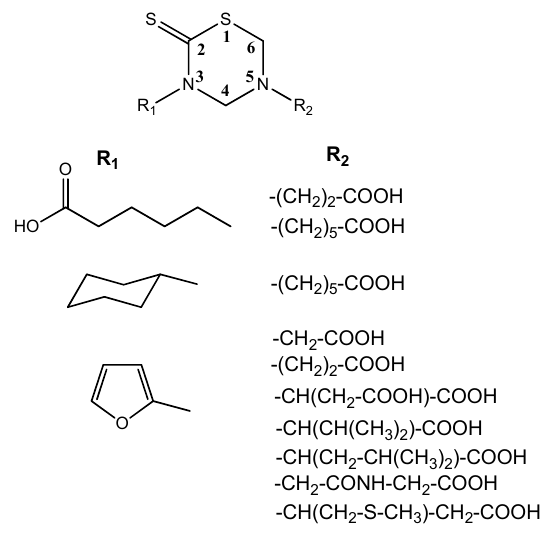
Figure 3. THTT derivatives characterized by NMR